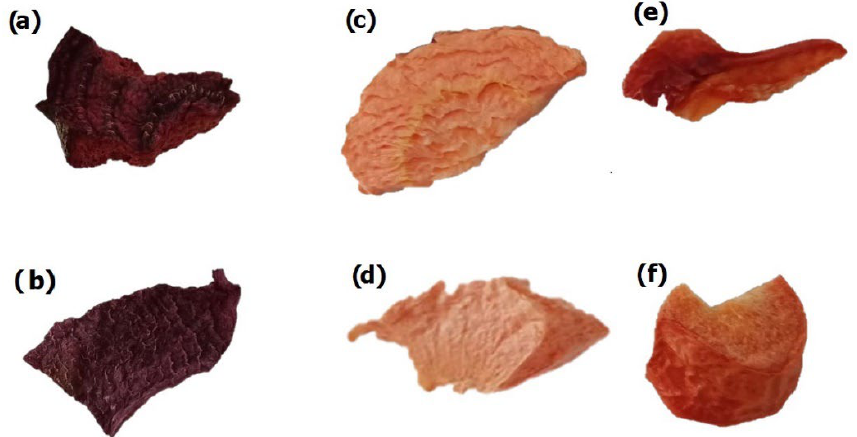
Figure 5. Structure of freeze-dried nonfermented and fermented vegetables (photo camera) ( a ) un- fermented beetroot; ( b ) fermented beetroot; ( c ) unfermented carrot; ( d ) fermented carrot; ( e ) unfer- mented red bell pepper; ( f ) fermented red bell pepper.